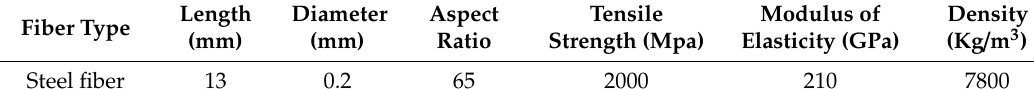
Table 3. Physical properties of steel fibers.